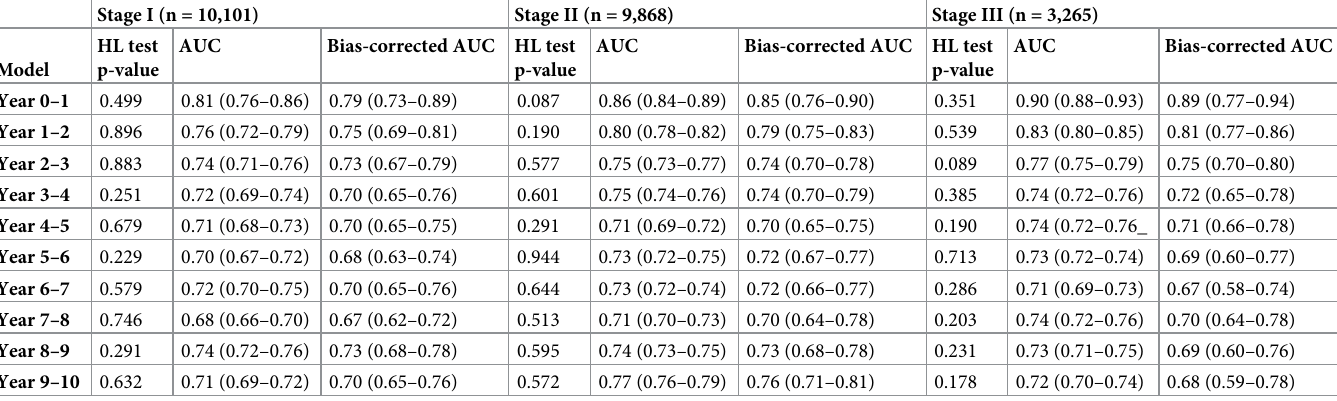
Abbreviations: HL = Hosmer-Lemeshow; AUC = Area under the receiver operating characteristic curve.